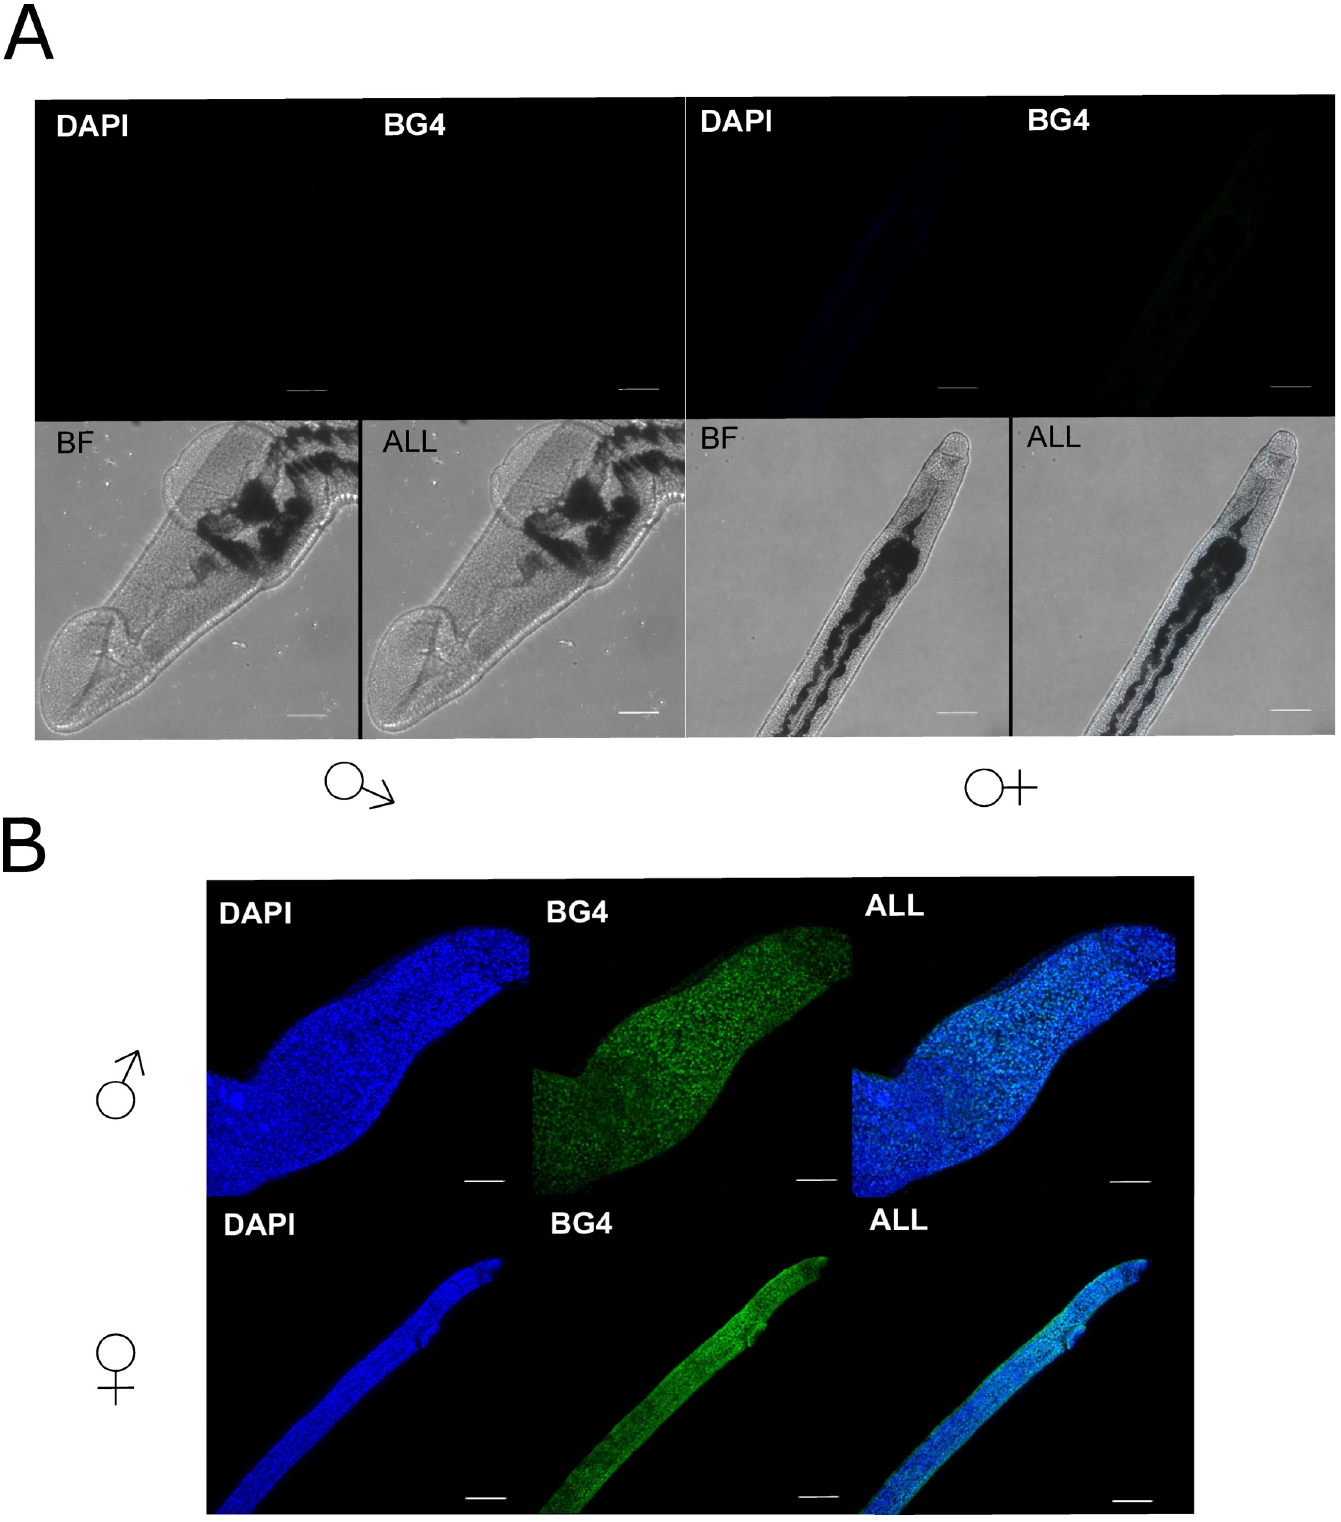
Fig 7. Adult schistosome G4 is predominantly found within DNA, and not RNA, pools. Schistosomes were either treated with A) 120 U DNase I or B) 0.1 mg/ml RNase A for 1 hr at 37˚C post permeabilisation and prior to blocking. Anterior sections from males and females were imaged using a Leica SP8 confocal microscope